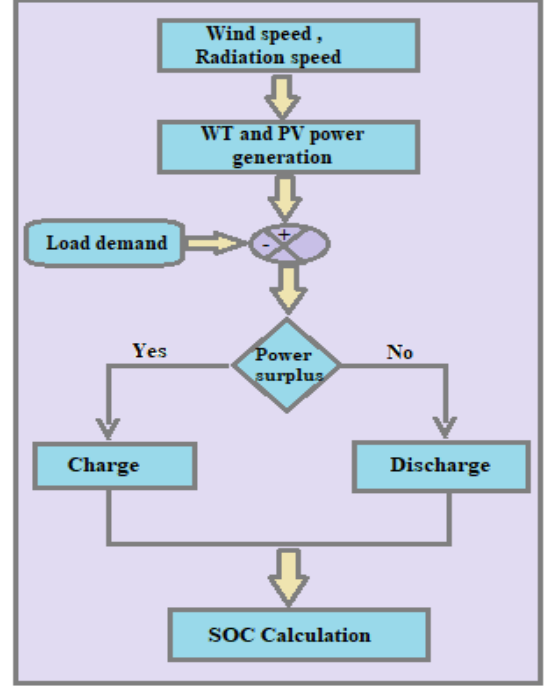
Figure 9. Algorithm of the control strategy.